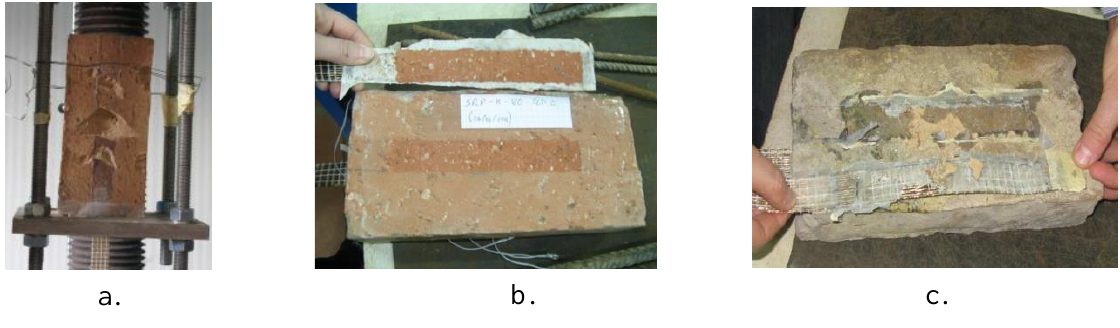
Figure 8. Detachment mechanisms: a . mechanism A; b . mechanism B; c . mechanism C.